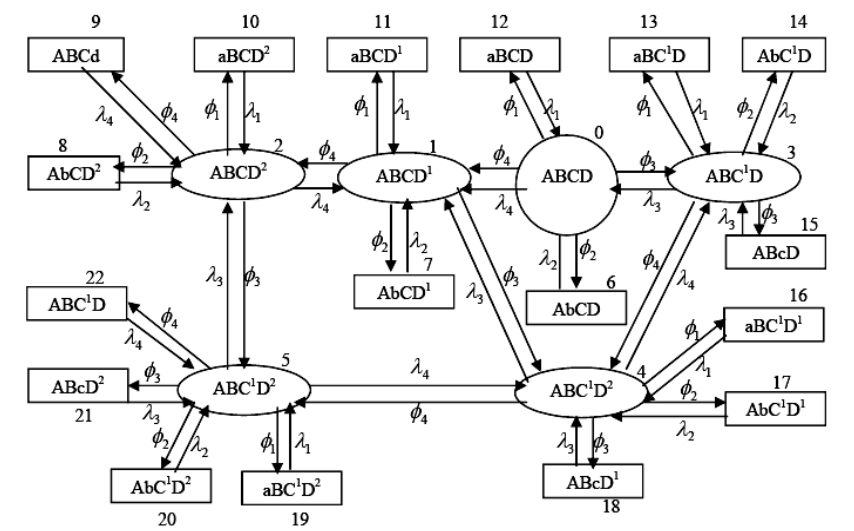
Figure 1. “Transition Diagram of flue gas and air